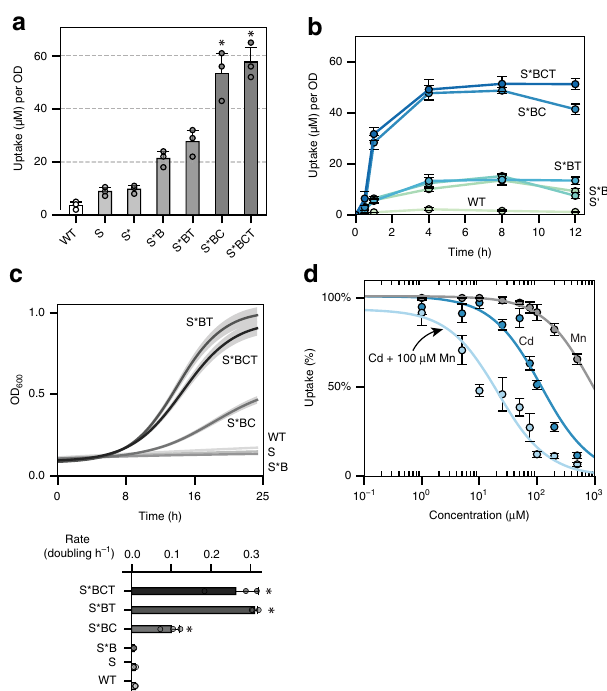
Fig. 3 Combining SMF1, CCC1, and TaPSC1 improved metal uptake capacity and tolerance. a SMF1 (S) and its modi fi cations (S* and Δ BSD2 as B) along with vacuole transporter CCC1 (C) and metal resistance enzyme TaPCS1 (T) incrementally enhanced cadmium uptake. Asterisk above bar charts represent signi fi cant increase in cadmium uptake when compared to WT ( p < 0.01). b Combinations of S*, B, C, and T showed changes in uptake rate, capacity, and metal retention over 12 h of metal incubation. c In the presence of 100 μ M cadmium, the growth rate is rescued with the addition of CCC1 and furthermore with TaPCS1. Sub fi gure below represents the doubling time of each strain. Asterisk to the side of bar charts represent signi fi cant increase in growth rate compared to WT ( p < 0.01). d S*BCT strain was titrated against cadmium, manganese, or cadmium in the presence of 100 μ M manganese ( x -axis). Metal uptake experiments were performed at varying concentrations from 1 μ M to 1 mM, metal content analyzed using ICP, and values reported as percent uptake. S*BCT showed a higher preference for manganese than cadmium, with cadmium uptake being dramatically reduced in the background presence of 100 μ M manganese (light blue curve). For all data, the mean ± s.d. of three replicates are shown. The source data underlying Figs. 3a, 3b, and 3d